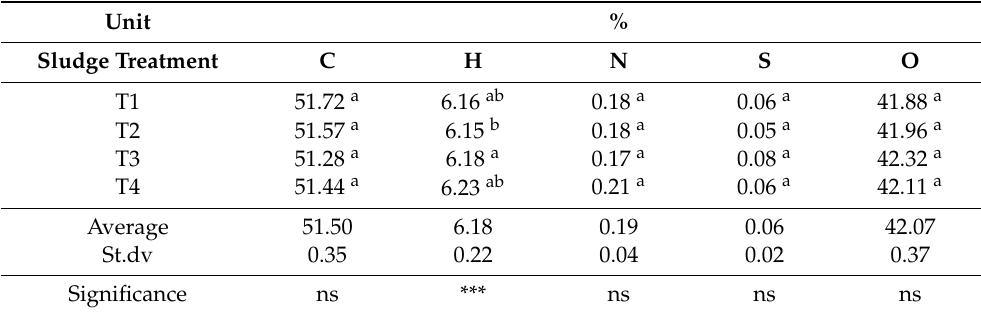
Table 6. Elemental analysis of Virginia mallow biomass after application of different amounts of sewage